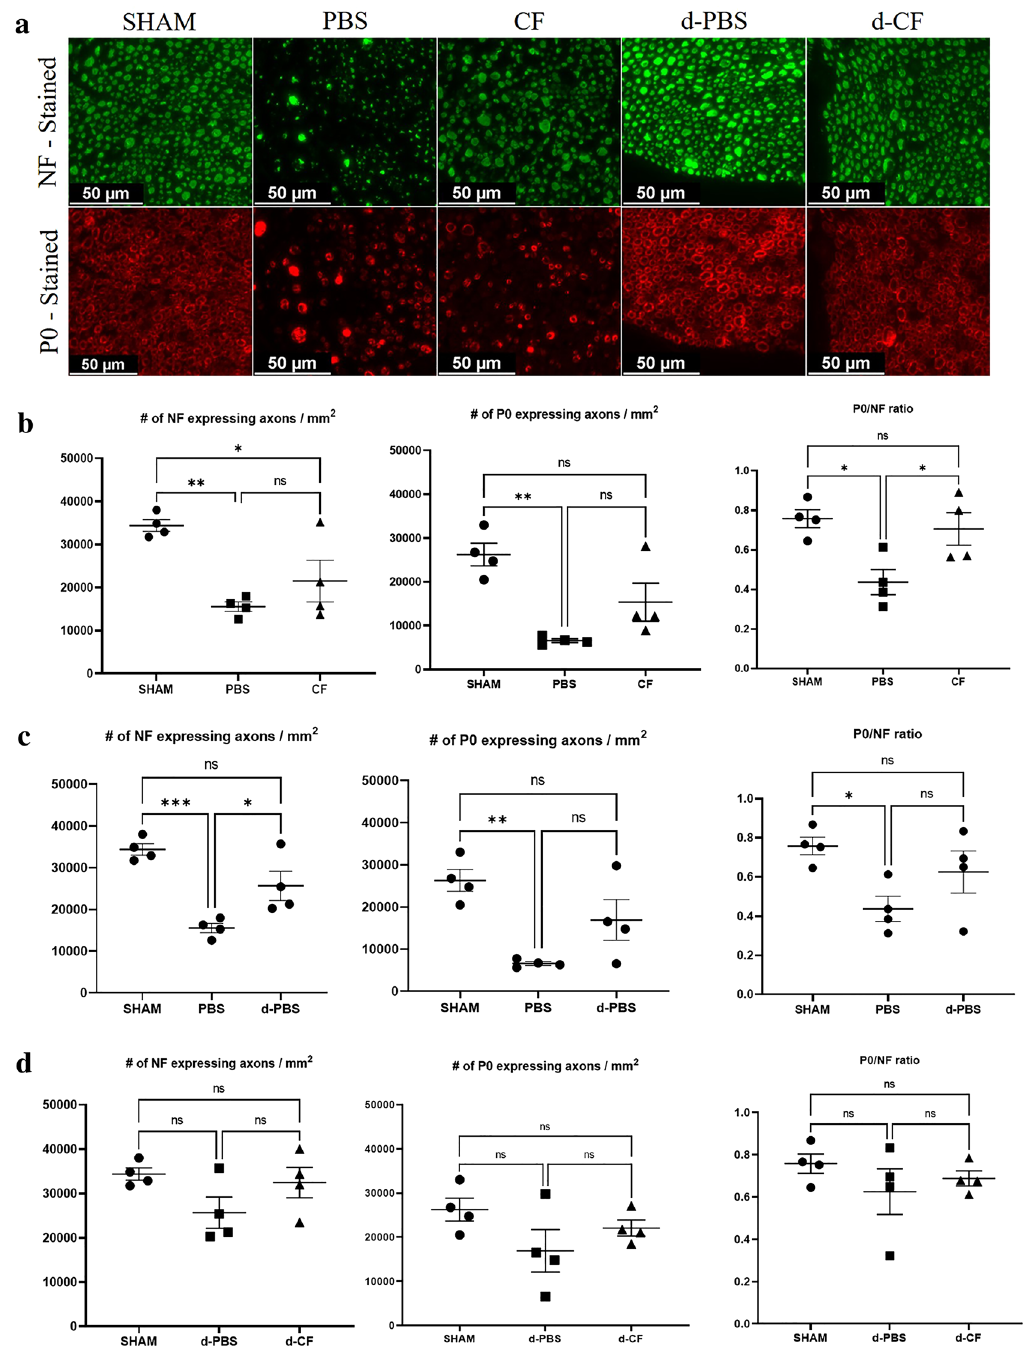
Figure 2. Representative cross-sectional images of the sciatic nerve upon immunofluorescence staining in the compression and decompression phase ( a ) (×400; scale bar = 50 μm; green, NF (neurofilament) heavy chain; red, P0 (myelin protein 0); Sham, nerves of sham-operated mice; PBS, nerves of untreated mice during compression phase; CF, nerves of mice treated with clemastine during compression phase; d-PBS, nerves of untreated mice after surgical decompression; d-CF, nerves of mice treated with clemastine after surgical decompression). Comparison of the number of NF- or P0-expressing axons/mm 2 and the ratio of P0/NF-expressing axons among sham, PBS, and CF group in the compression phase ( b ). Comparison of these measurements among sham, PBS, and d-PBS group for evaluation of decompression effect ( c ). Comparison of these measurements among sham, d-PBS, and d-CF group in decompression phase ( d ). Error bars represent standard error of mean. One-way ANOVA with Turkey’s post-hoc test was conducted (*p < 0.05, **p < 0.01, and n = 4